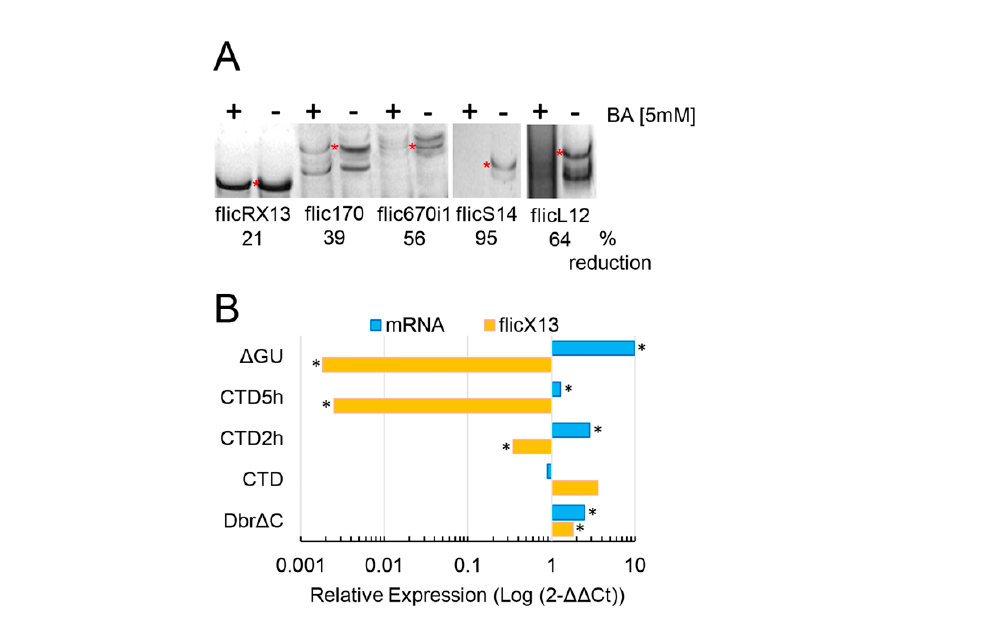
Figure 2. Inverse correlation of flicX13 and RabX13 gene expression. ( A ) 5 mM boric acid (BA) reduces the production of flicRNAs flicX13 (lanes 1–2), flic170 (lanes 3–4), and flic670i1 (asterisks in lanes 5–6), assessed by circular RT-PCR using specific primers and total RNA isolated from BA treated (+) and untreated ( − ) amoebas. DNA fragments were visualized on 2.5% agarose gels. Densitometric analyses of the results are shown above. ( B ) RT-qPCR was used to monitor the effect of BA, for 2 and 5 h, on the production of flicX13 and the expression of mRabX13 in Pol II-CTD transfectants (CTD). As controls, we used untreated Dbr ∆ C and ∆ GU trophozoites. They elicit flicRNA accumulation/slight mRNA reduction and flicRNA reduction/mRNA accumulation, respectively. Relative expression of RNA variants is presented compared to one in the HA control. Logarithmic values are the average of three independent experiments; statistically significant results (ANOVA and Turkey test a posteriori. p ≤ 0.01, *) are shown.